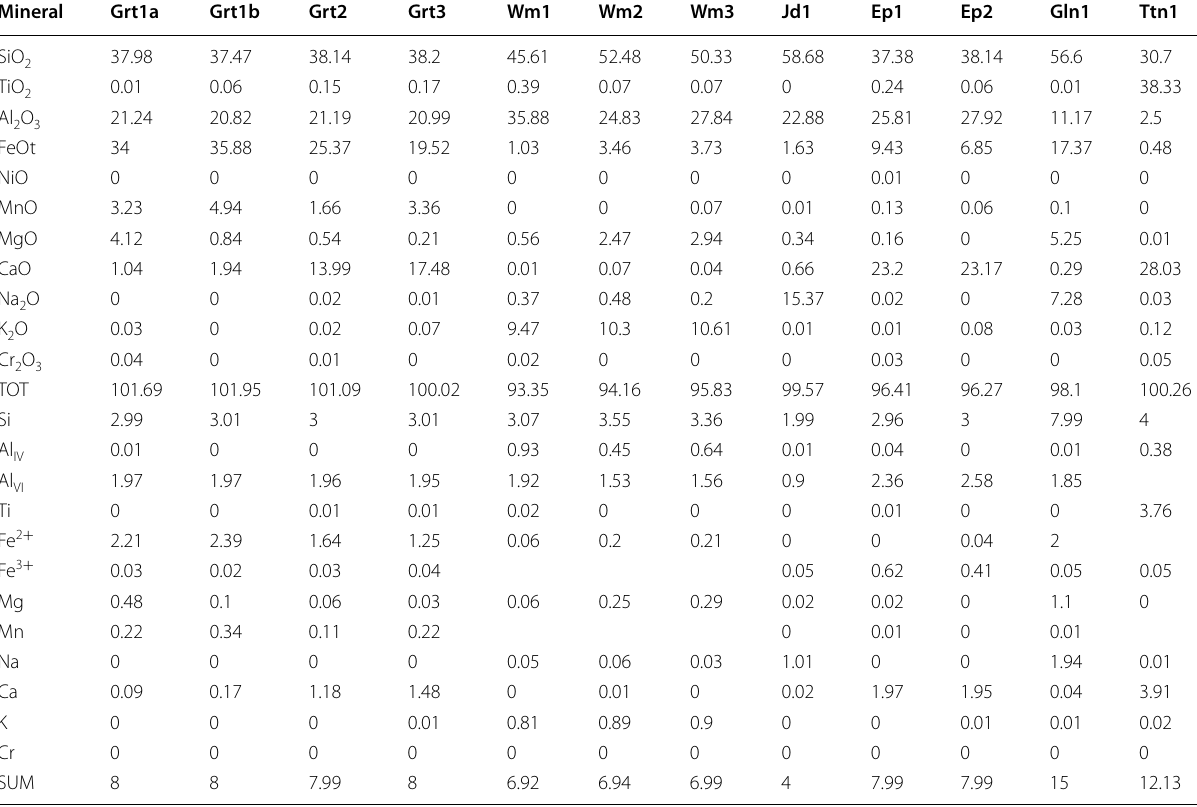
Table 5 Representative analysis of main minerals of garnet-bearing gneiss (ZR4) Mineral Grt1a TiO